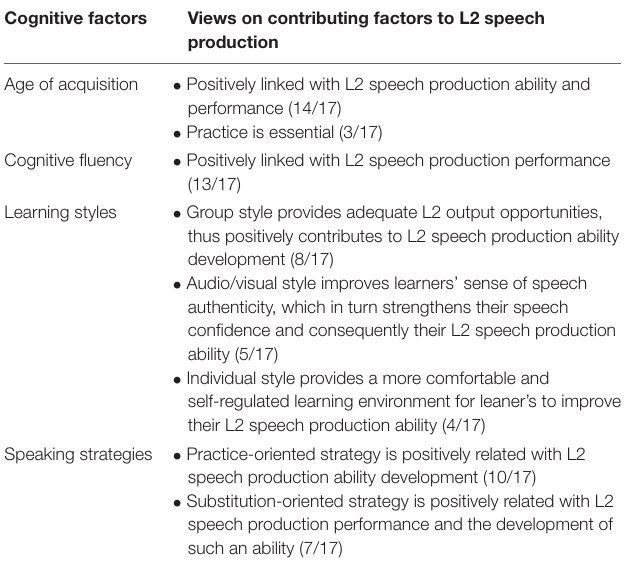
TABLE 2 | Cognitive dimensions of multilinguals’ L2 Chinese speech production. Cognitive factors Views on contributing factors to L2 speech